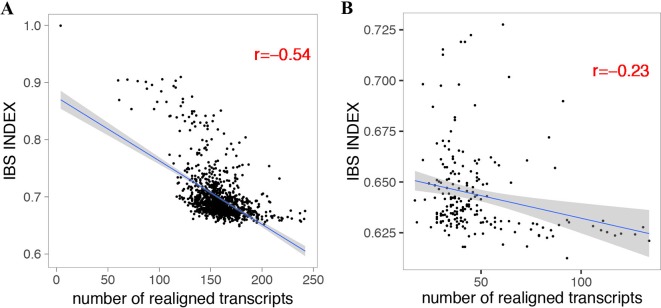
Correlation between the number of realigned transcripts by the ZSDP method and identical by state index for A. thaliana
(A) and D. melanogaster
(B).